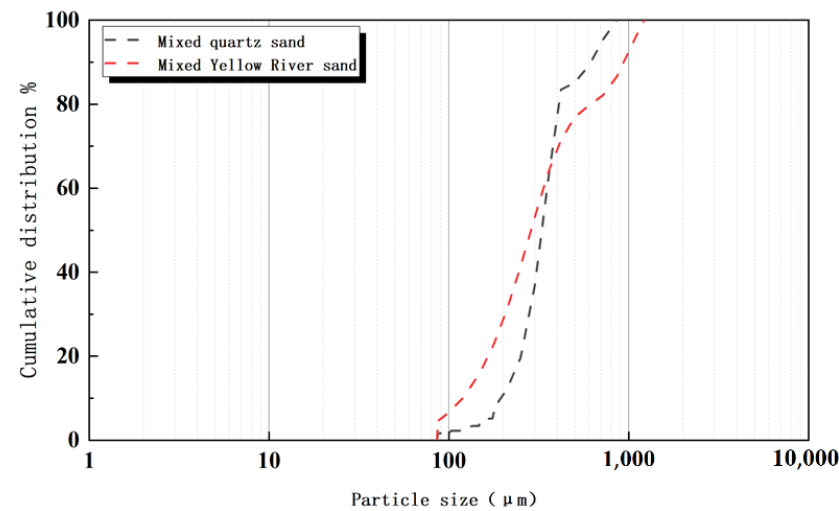
Figure 8. Particle size distribution of mixed sand and quartz sand after mixing. Table 2. Mix proportions of ultra-fine Yellow River sand for ultra-high-performance concrete (kg/m 3 ).